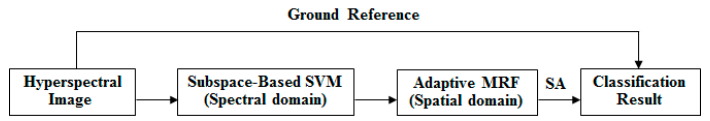
Figure 1. General framework of the proposed methods.